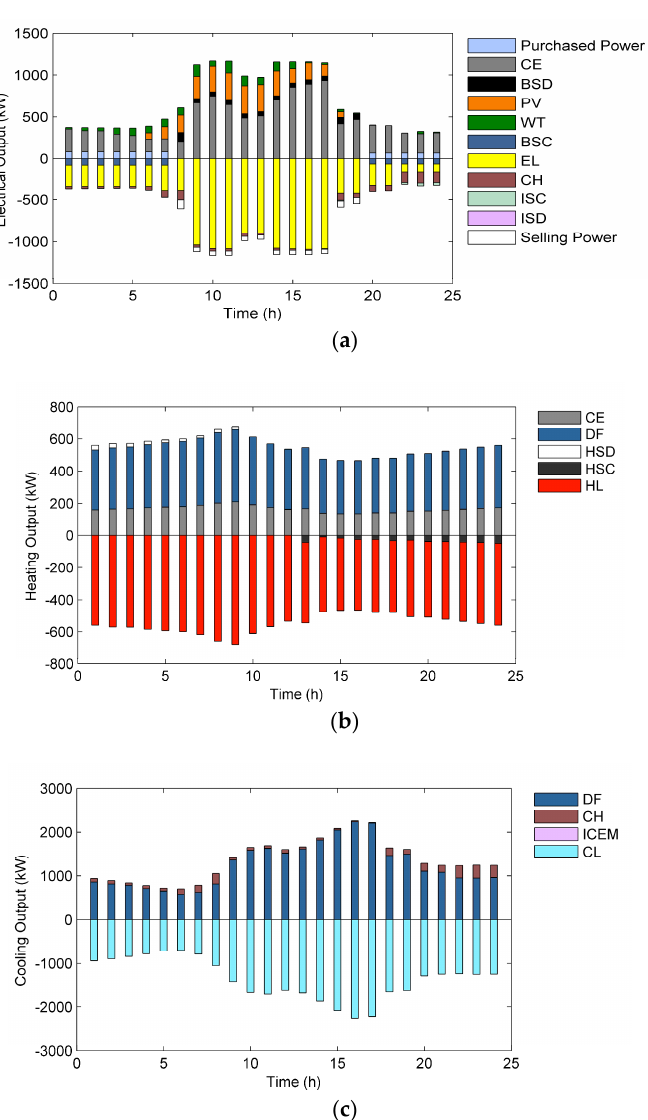
Figure 11. Optimal outputs of MEG in Scenario 3. ( a ) The optimal electrical outputs; ( b ) The optimal heating outputs; and, ( c ) The optimal cooling outputs.